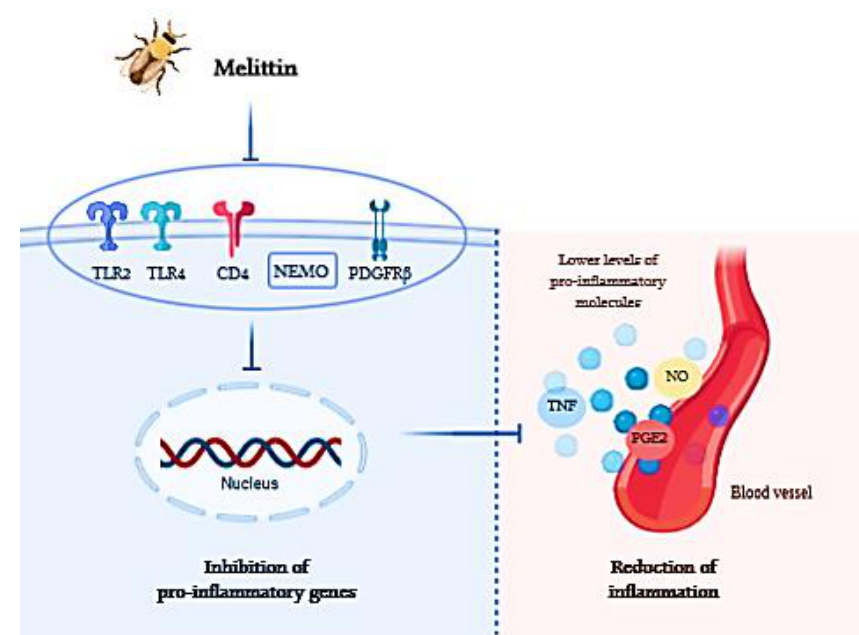
Figure 2. Action mechanism of anti-inflammatory effects of melittin. Melittin inhibits the routes of TLR2, TLR4, CD4, NEMO and PDGFRβ and therefore, inhibits the action of pro-inflammatory genes. This process results in lower levels of pro-inflammatory molecules and the reduction of inflammation.